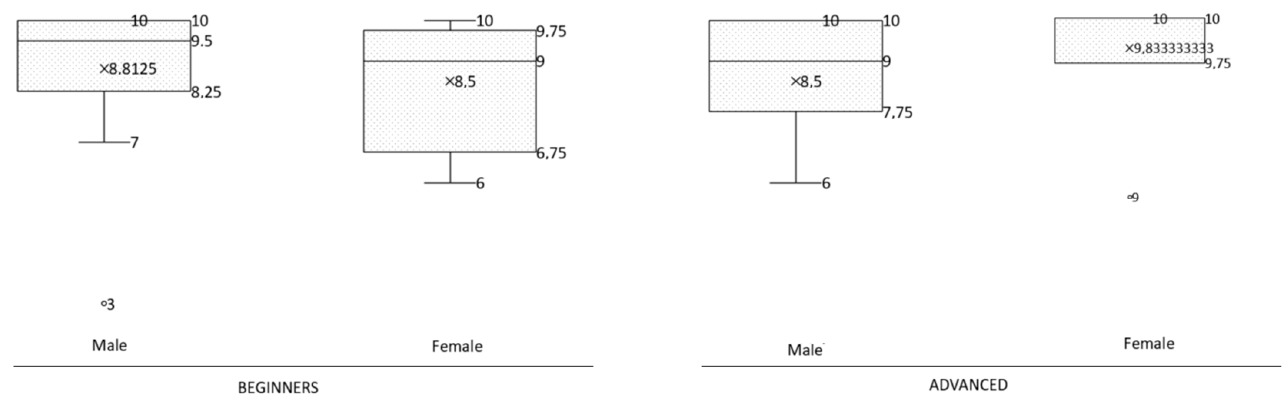
Figure 8. Average of the results by gender of the experimental group (EG).